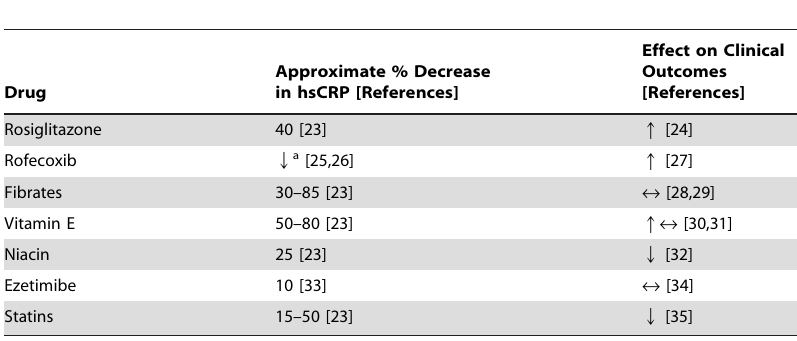
Table 2. Examples of drugs that lower hsCRP and the impact these drugs have had on clinical